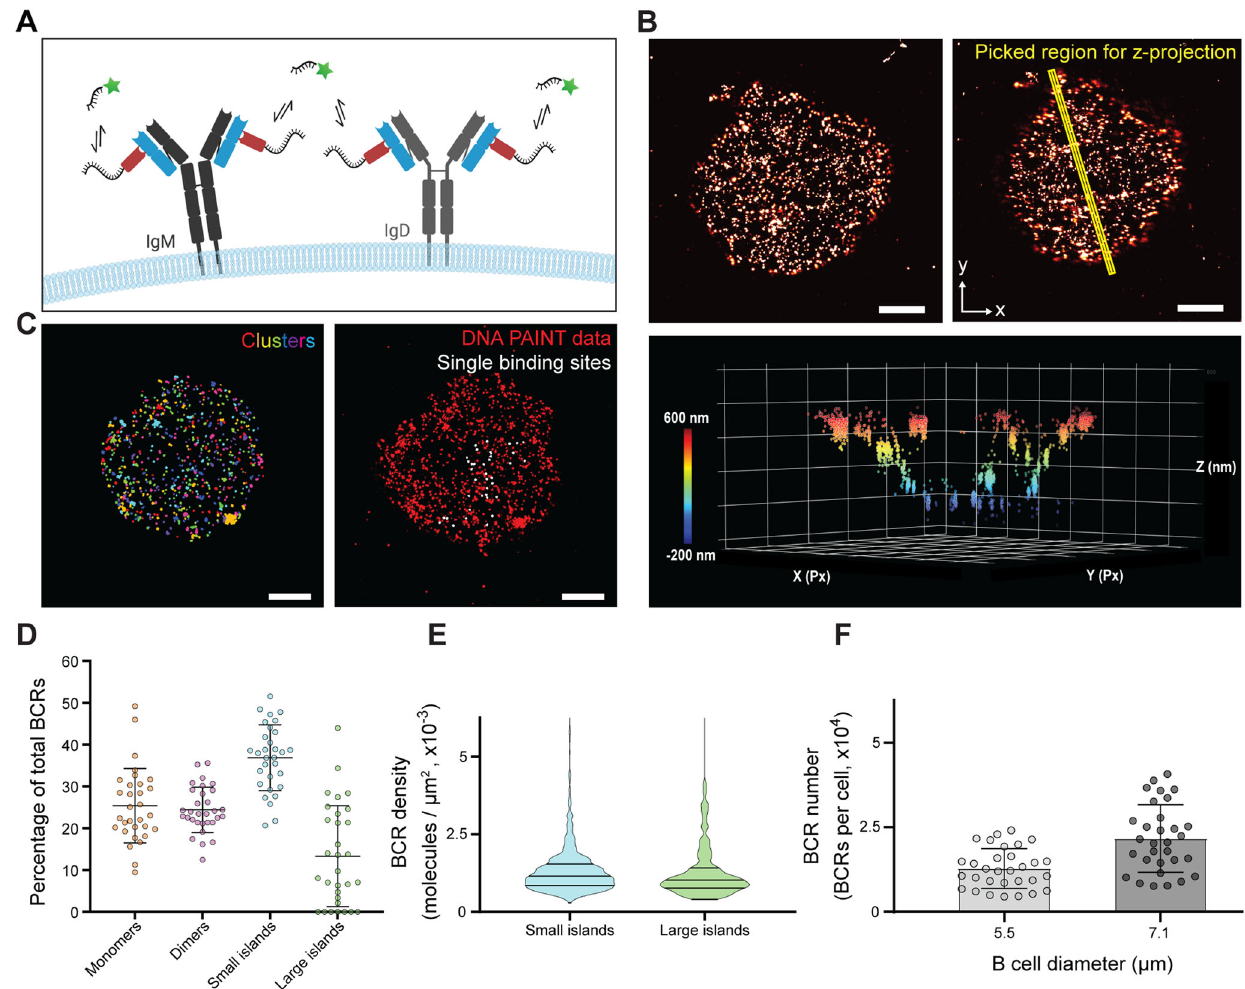
Fig. 1 | B cell receptor distribution of resting, naïve murine B cells. A An anti- mouse kappa light chain Nb ( κ LC-Nb) which binds both IgM and IgD BCRs, con- jugated site-speci fi cally to a single docking strand, was used for imaging by the DNA-PAINT method (kappaLc: blue; Nb: red; DNA: black; Cy3b: green). B Both 2D (topleftpanel)and3D(bottompanel)imagesoftheBCRswereacquired.Plottinga rectangular region in xyz (top right panel) shows a preservation of the round architecture of B cells (bottom panel). Px, pixels. C To extract the information on thenumberofBCRsontheBcellsurfacealongwiththesurfacearea,representative regions of the imaged B cells wereanalyzedby DBSCAN cluster analysis to identify clusters(leftpanelandSupplementaryFig.4).Forkineticcalibration,singlebinding sites were picked (right panel, and Supplementary Fig. 2). Imaging data are